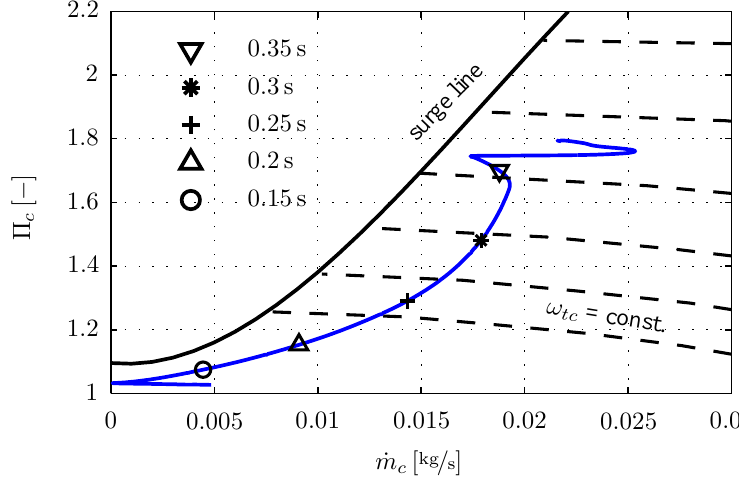
at 2000 rpm. The markers indicate the me